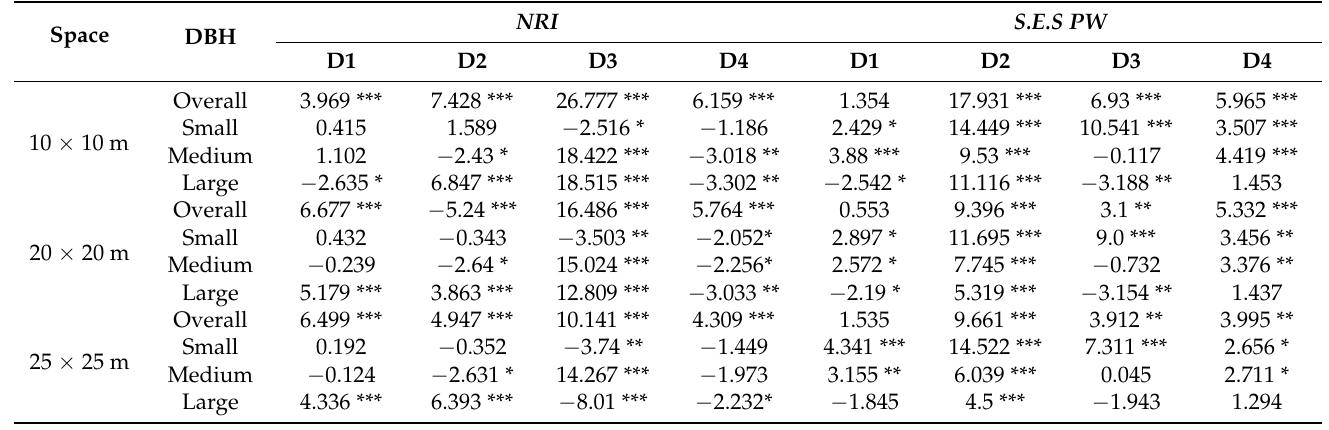
Table 3. Results of t − test for the hypothesis that the mean values of NRI and S.E.S PW is zero at different spatial scales and DBH classes in four disturbance regimes. D1, D2, D3, and D4 represent the plantation, twice-cut, once-cut, and old-growth forests, respectively. “*”, “**”, and “***” represent p < 0.05, p < 0.01, and p < 0.001, respectively.